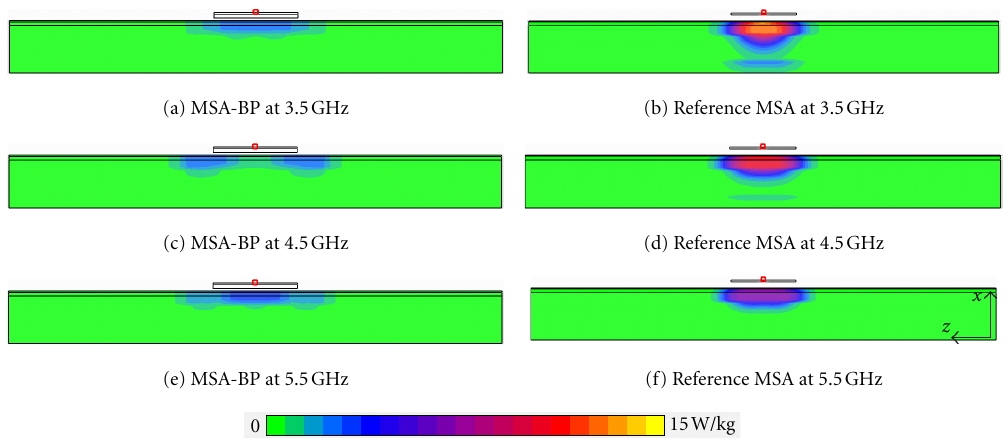
Figure 15: SAR distribution of MSA-BP and reference MSA antenna (6.5mm from radiation layer to